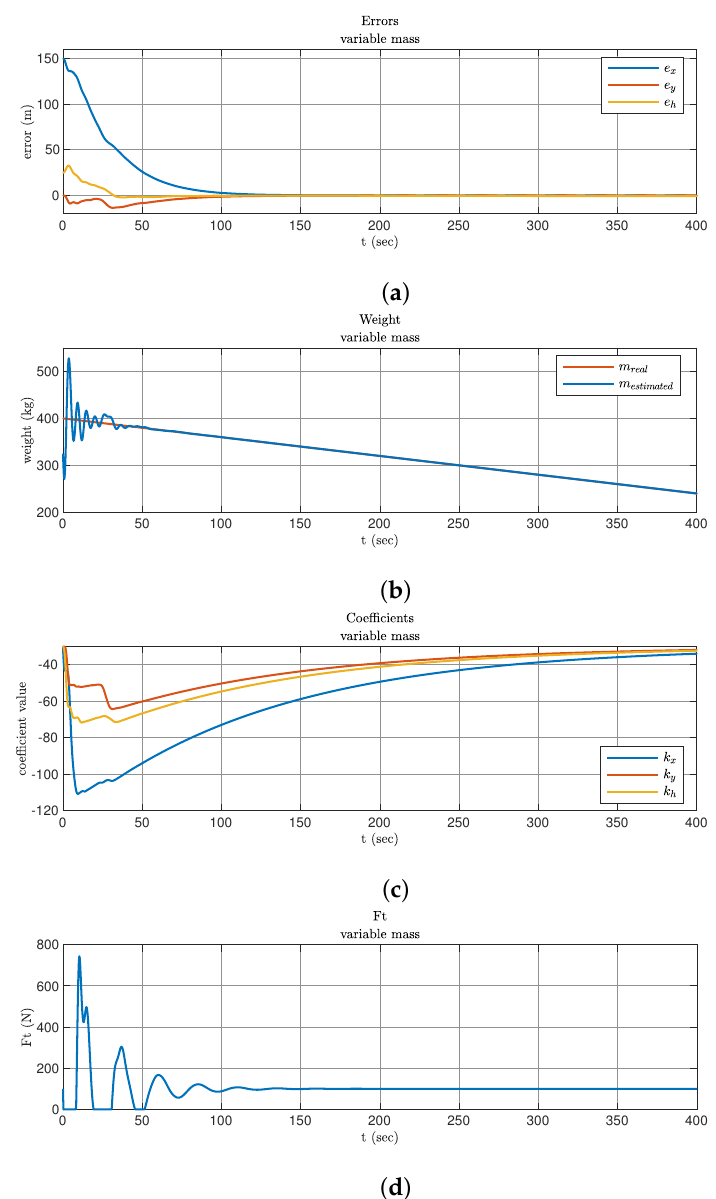
Figure 4. Coordinate errors ( a ), estimated mass value ( b ), controller gains ( c ), and thrust force ( d ) for a scenario in which the UAV mass changes linearly over